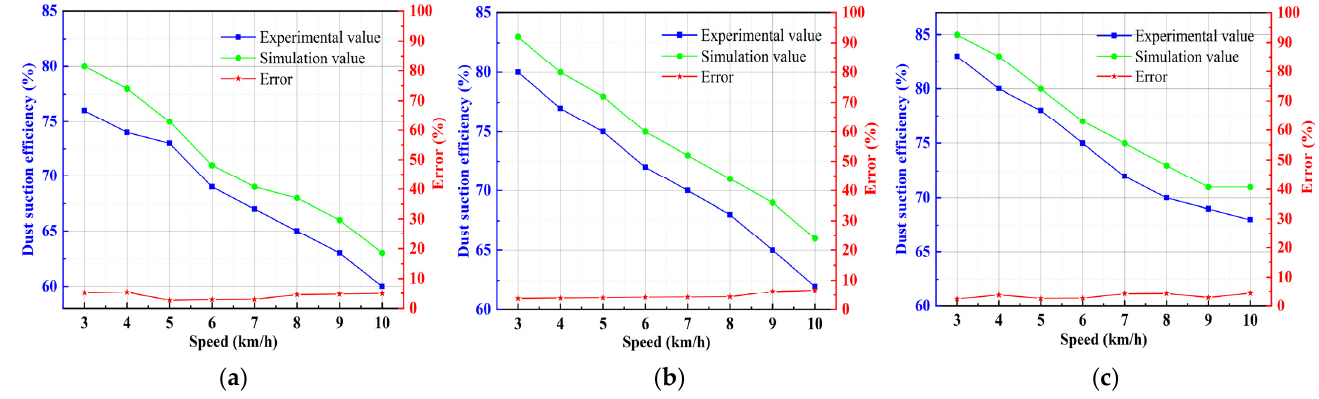
Figure 18. Comparison of simulated and experimental dust extraction efficiency at different driving speeds and negative pressures: ( a ) vacuum efficiency at different vehicle speeds at 2400 Pa; ( b ) vac- uum efficiency at different vehicle speeds at 2800 Pa; ( c ) comparison of simulated and experimental dust extraction efficiency at different driving speeds and negative